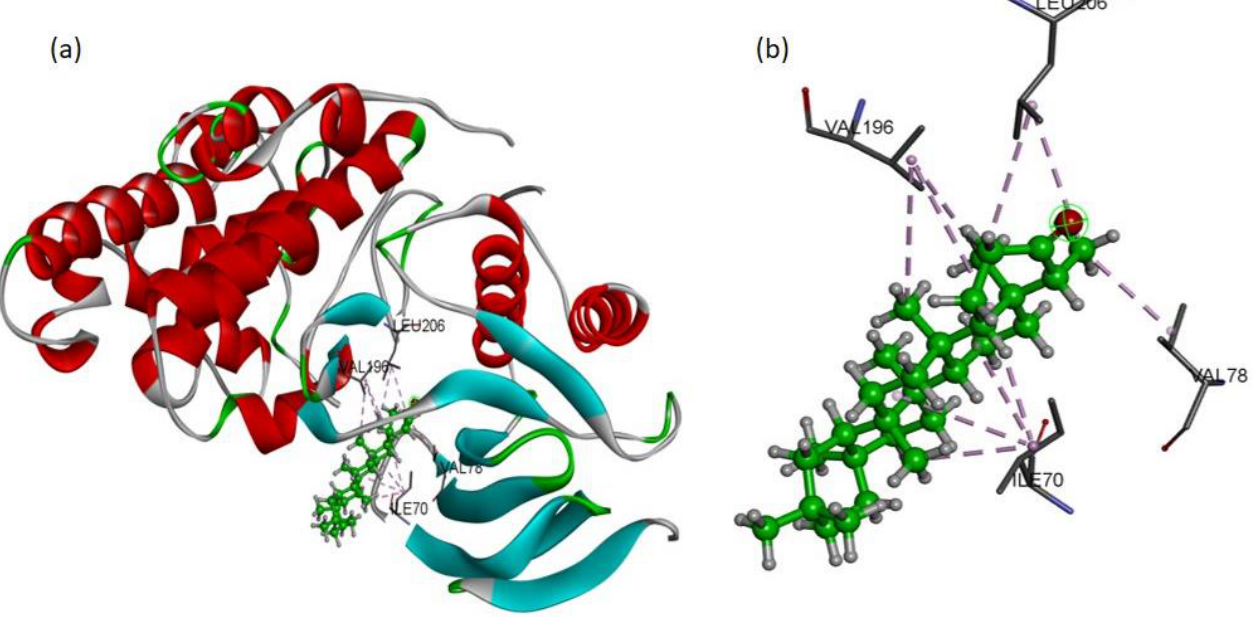
Figure 6. Docking pose of friedelin with p-JNK ligand. ( a ) Friedelin’s binding mode as inhibitor of JNK; the ligand is presented in a bright green color ( b ) 3D binding mode of friedelin with active site residues showing alkyl hydrophobic interactions (shown by purple dashed lines).